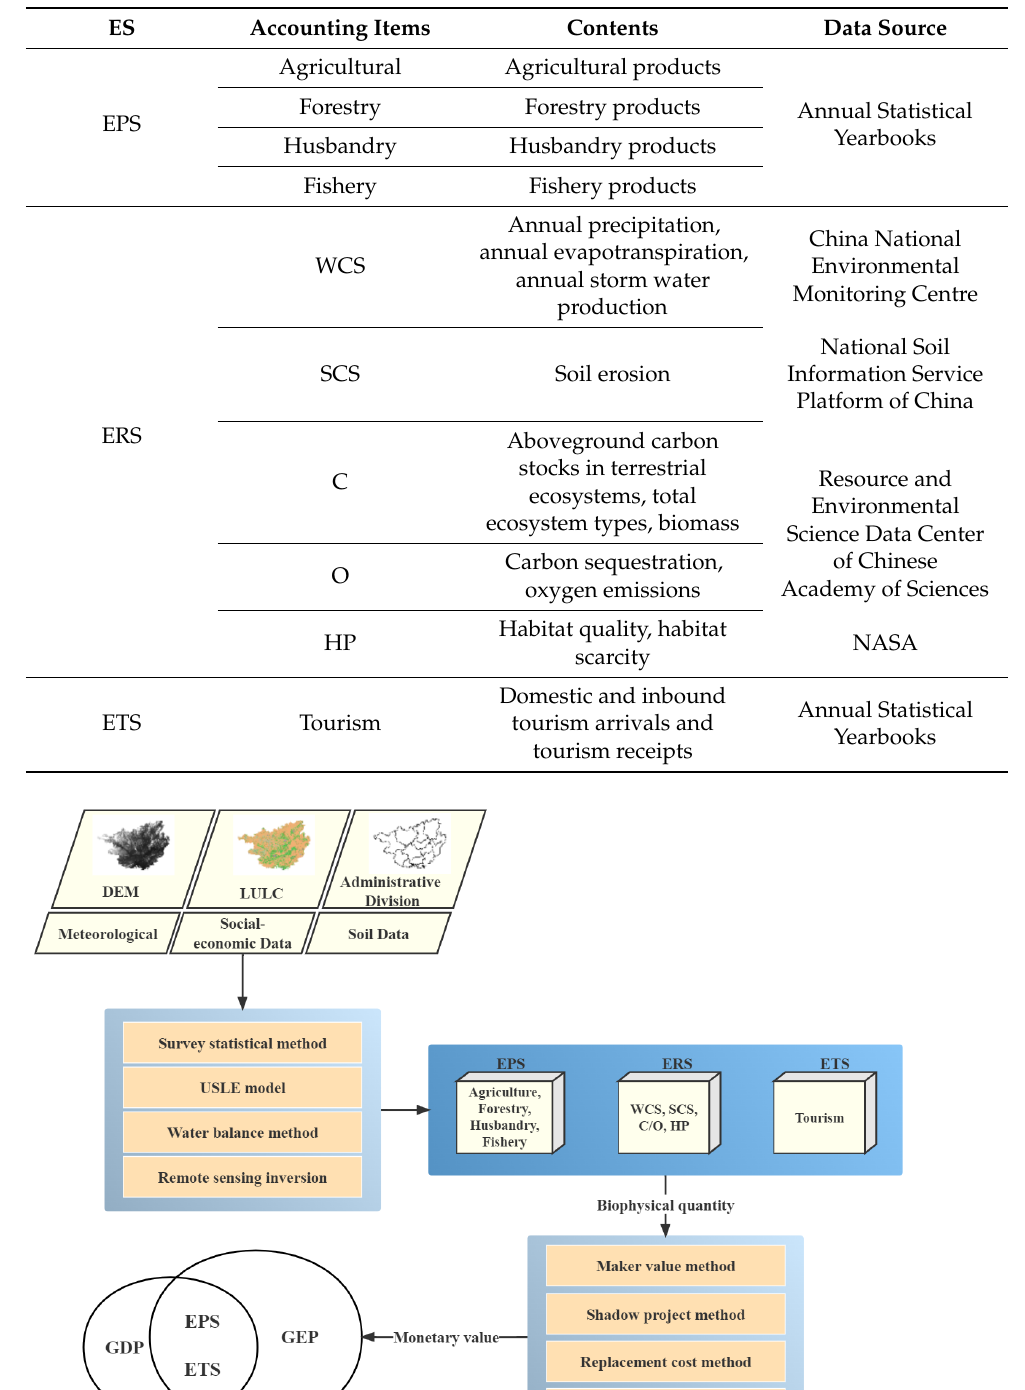
Table 1. Elements of accounting for different ecosystem services. The GEP accounting examined three aspects of ecosystem provisioning services (EPSs), ecosystem regulation services (ERSs) and ecosystem tourism services (ETSs), with agriculture, forestry, animal husbandry, fishery, water conservation service (WCS), soil conservation service (SCS), carbon sequestration and oxygen release service (C/O), habitat provision (HP), and tourism services selected as accounting items.